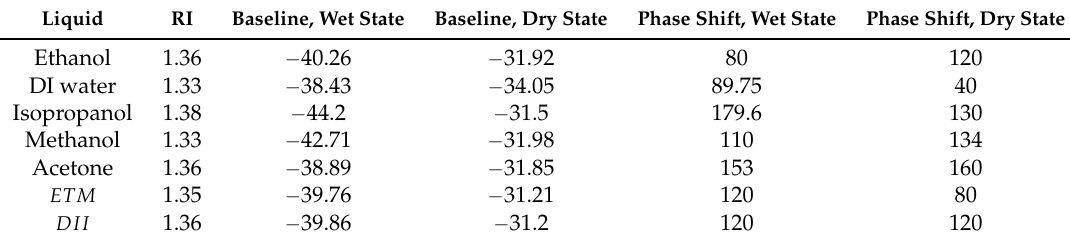
Figure 7. Recognition plots in parameter space. ( a ) Pure liquids as well as ETM mixture (the latter denoted as M); ( b ) isopropanol, DI water, and DII compound plotted separately. Table 1. Summary of data relevant to the defined principal components as extracted from the